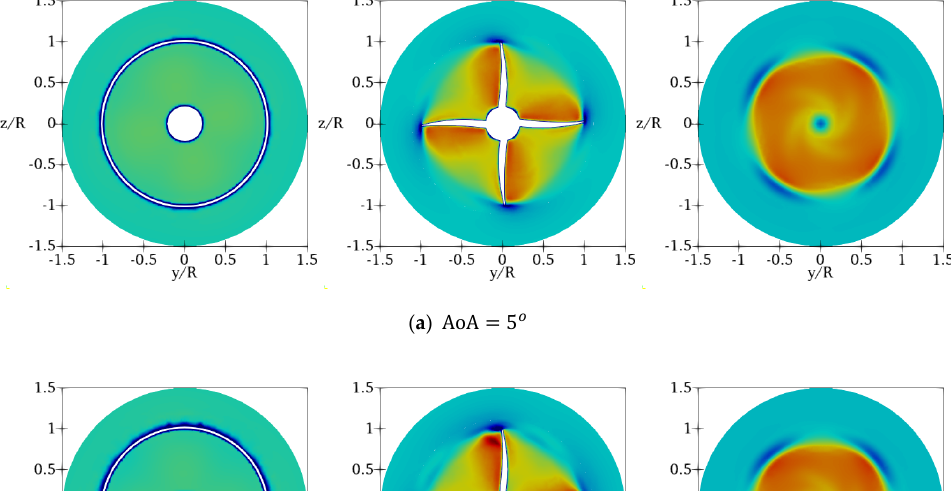
Figure 8. Instantaneous non-dimensional axial velocity contours at 𝑥/𝑅 = − 0.5, 0, and 1.5 for 𝐷 (cid:3005) = 0.7𝐷 (cid:3017) (left: 𝑥/𝑅 = − 0.5; middle: 𝑥/𝑅 = 0 ; right: 𝑥/𝑅 = 1.5 ).